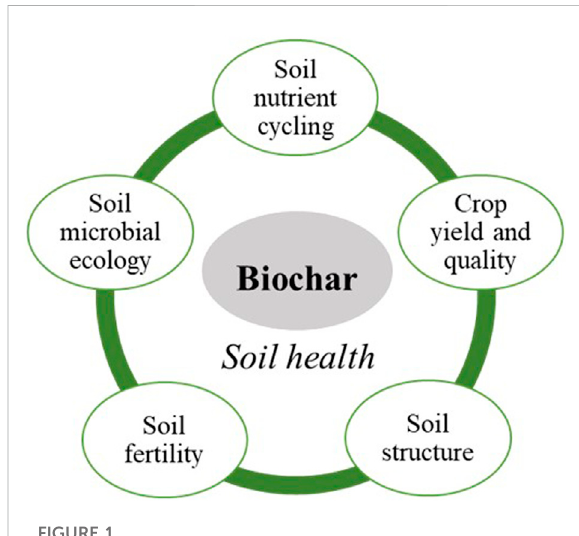
FIGURE 1 Thethematicconceptsoftopicsinvolvedinthisspecial